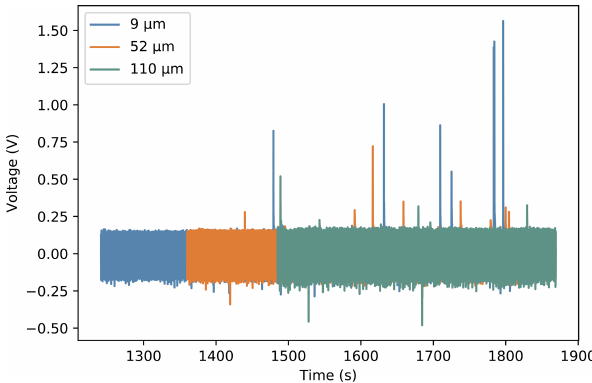
Figure 3. Sections of voltage time graphs for three different thick- nesses of PVDF overlaid on top of each other. Each positive spike represents the freezing of a microlitre droplet of pure water. The offset at the start shows the similar noise amplitude for each thick-